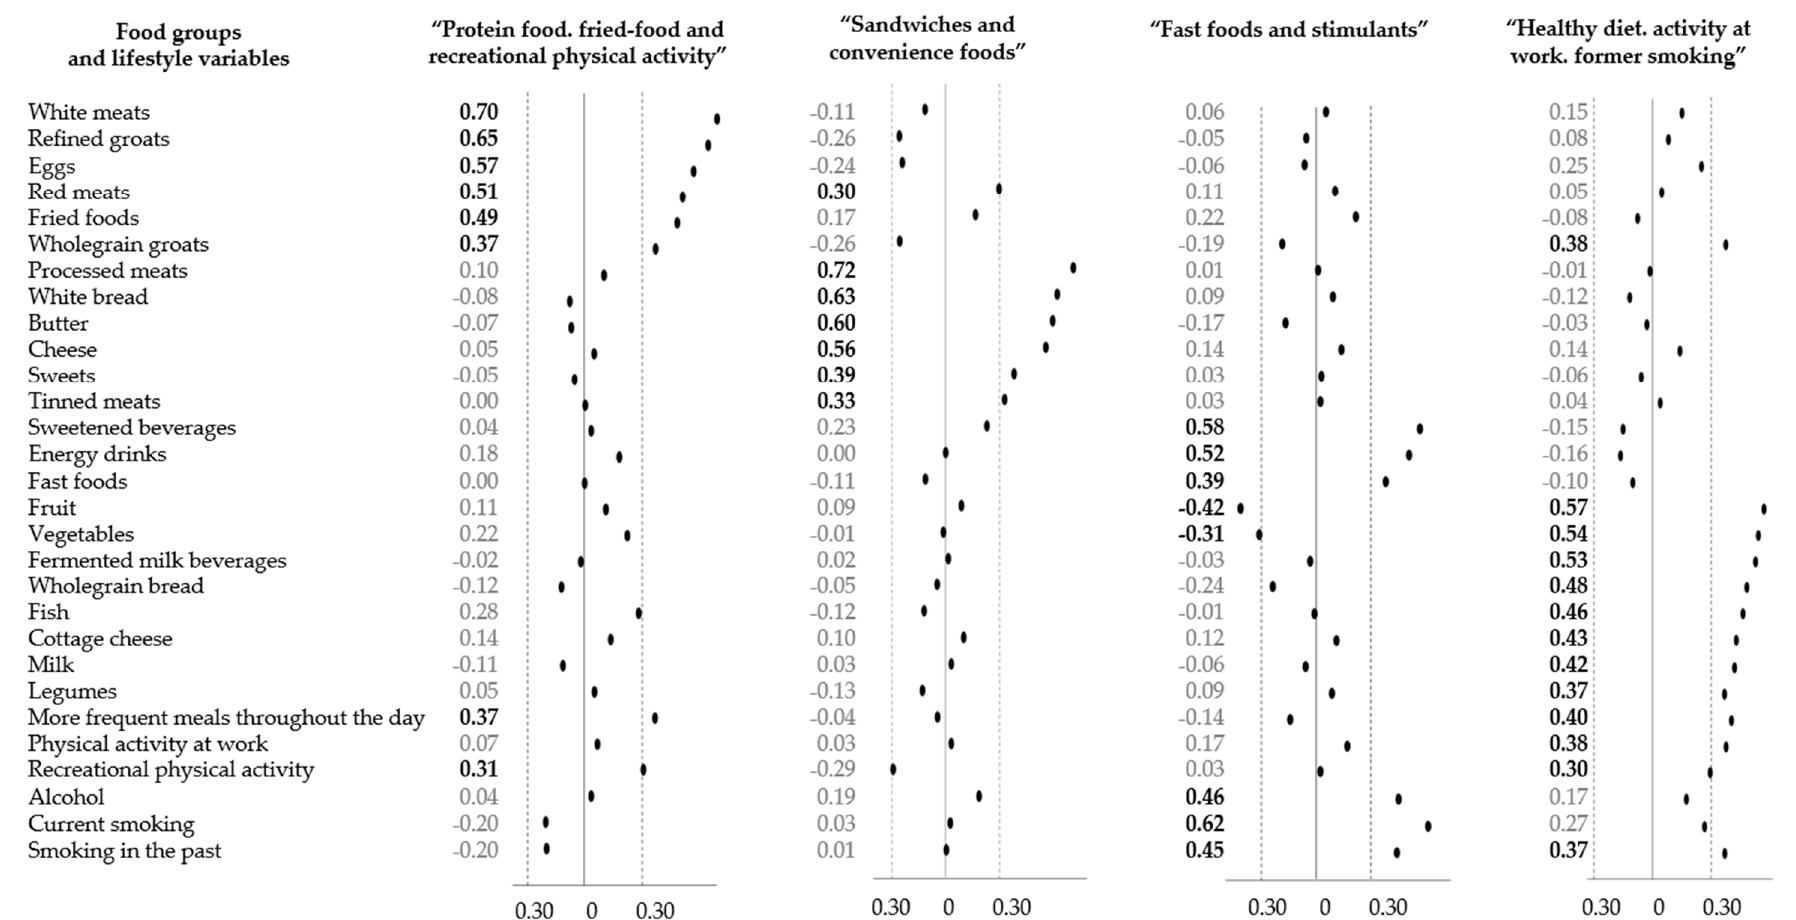
Figure 2. Black dots represent numerical values of factors loadings characterising each dietary-lifestyle pattern identified with principal component analysis [25]. Bold font represents items with factor loading ≥ |0.30|.